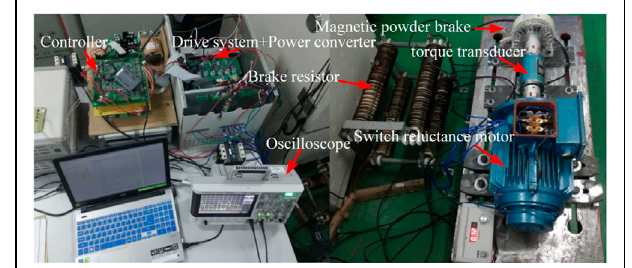
FIGURE 11 | Hardware of the experimental system. Figure 10 . The maximum angle error of the control